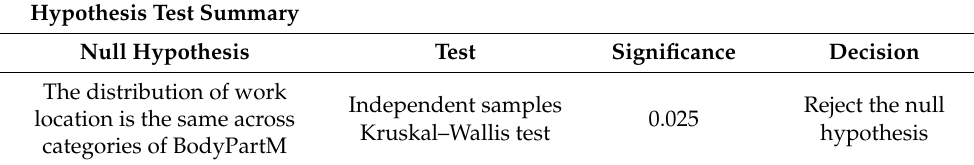
Table 12. Hypothesis test